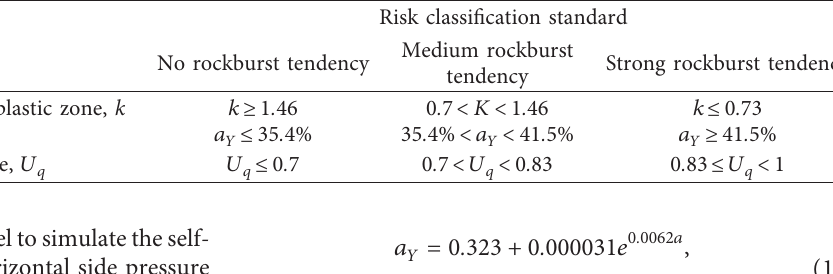
Table 1: Rockburst risk indexes of strip coal